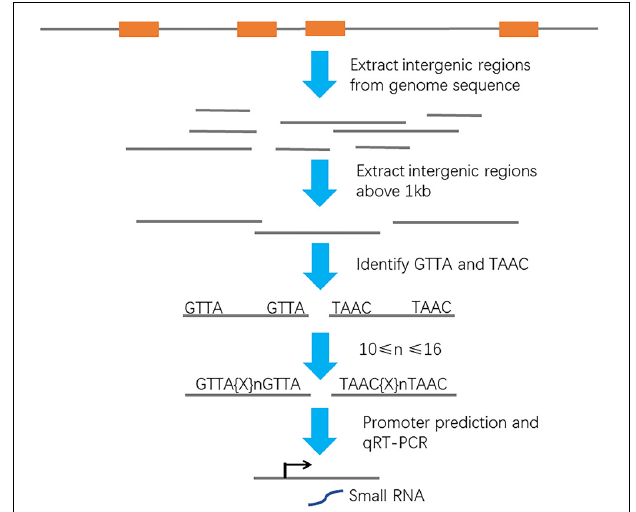
FIGURE 1 | Schematic of a bioinformatic screen setup to identify ArcA-binding promoters. Orange box, protein-encoding gene. Gray line, intergenic region. Black arrow, transcription start